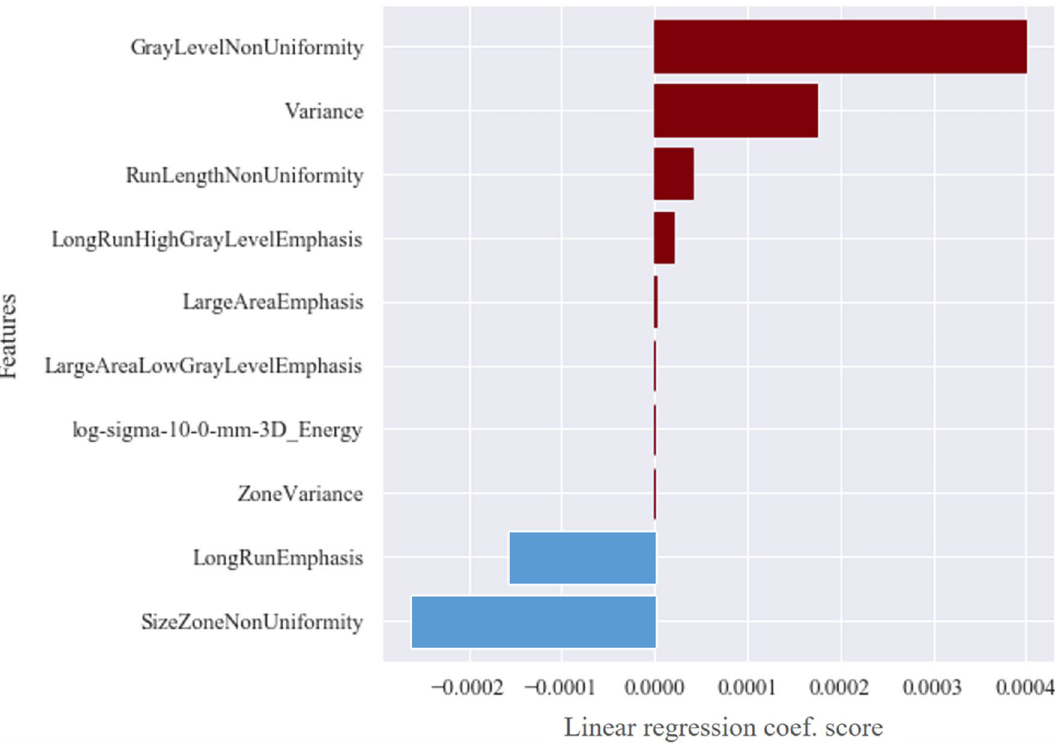
Figure 5. Selected 10 features by Lasso regression efficient score. 8 features showed positive coefficient scores (red) while 2 features showed negative coefficient scores